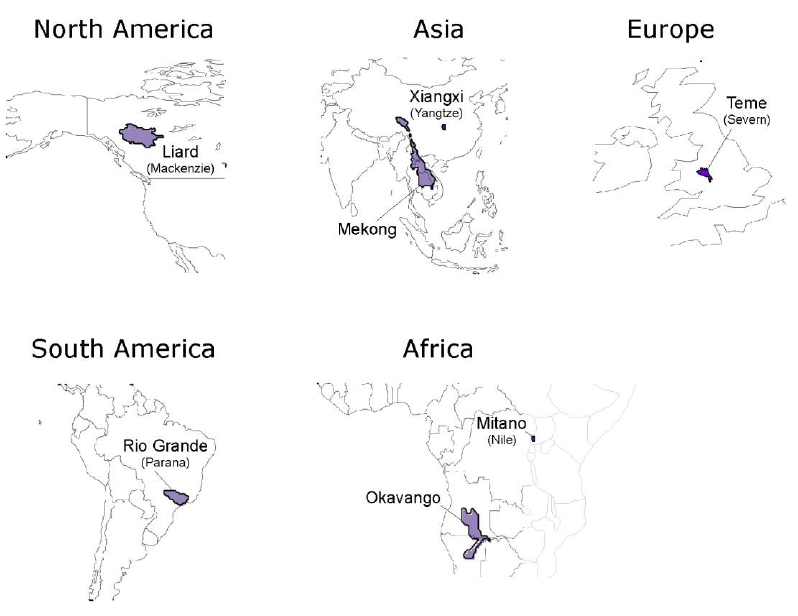
Fig. 1. Maps of the study river